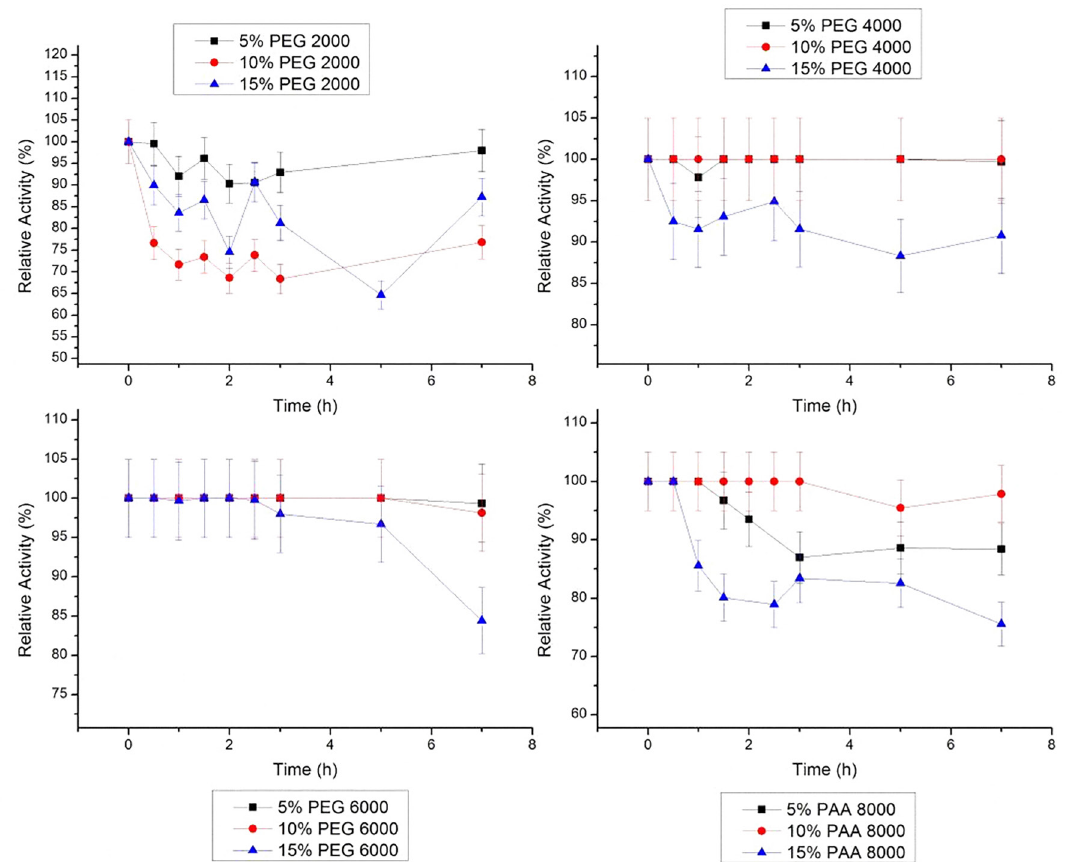
FIGURE 5 - Relative stability of bromelain at 20 ºC in PEG 2000, 4000, 6000 g/mol and PAA 8000 g/mol at three concentrations (5, 10 and 15% w/w). The error bars refer to standard deviation.